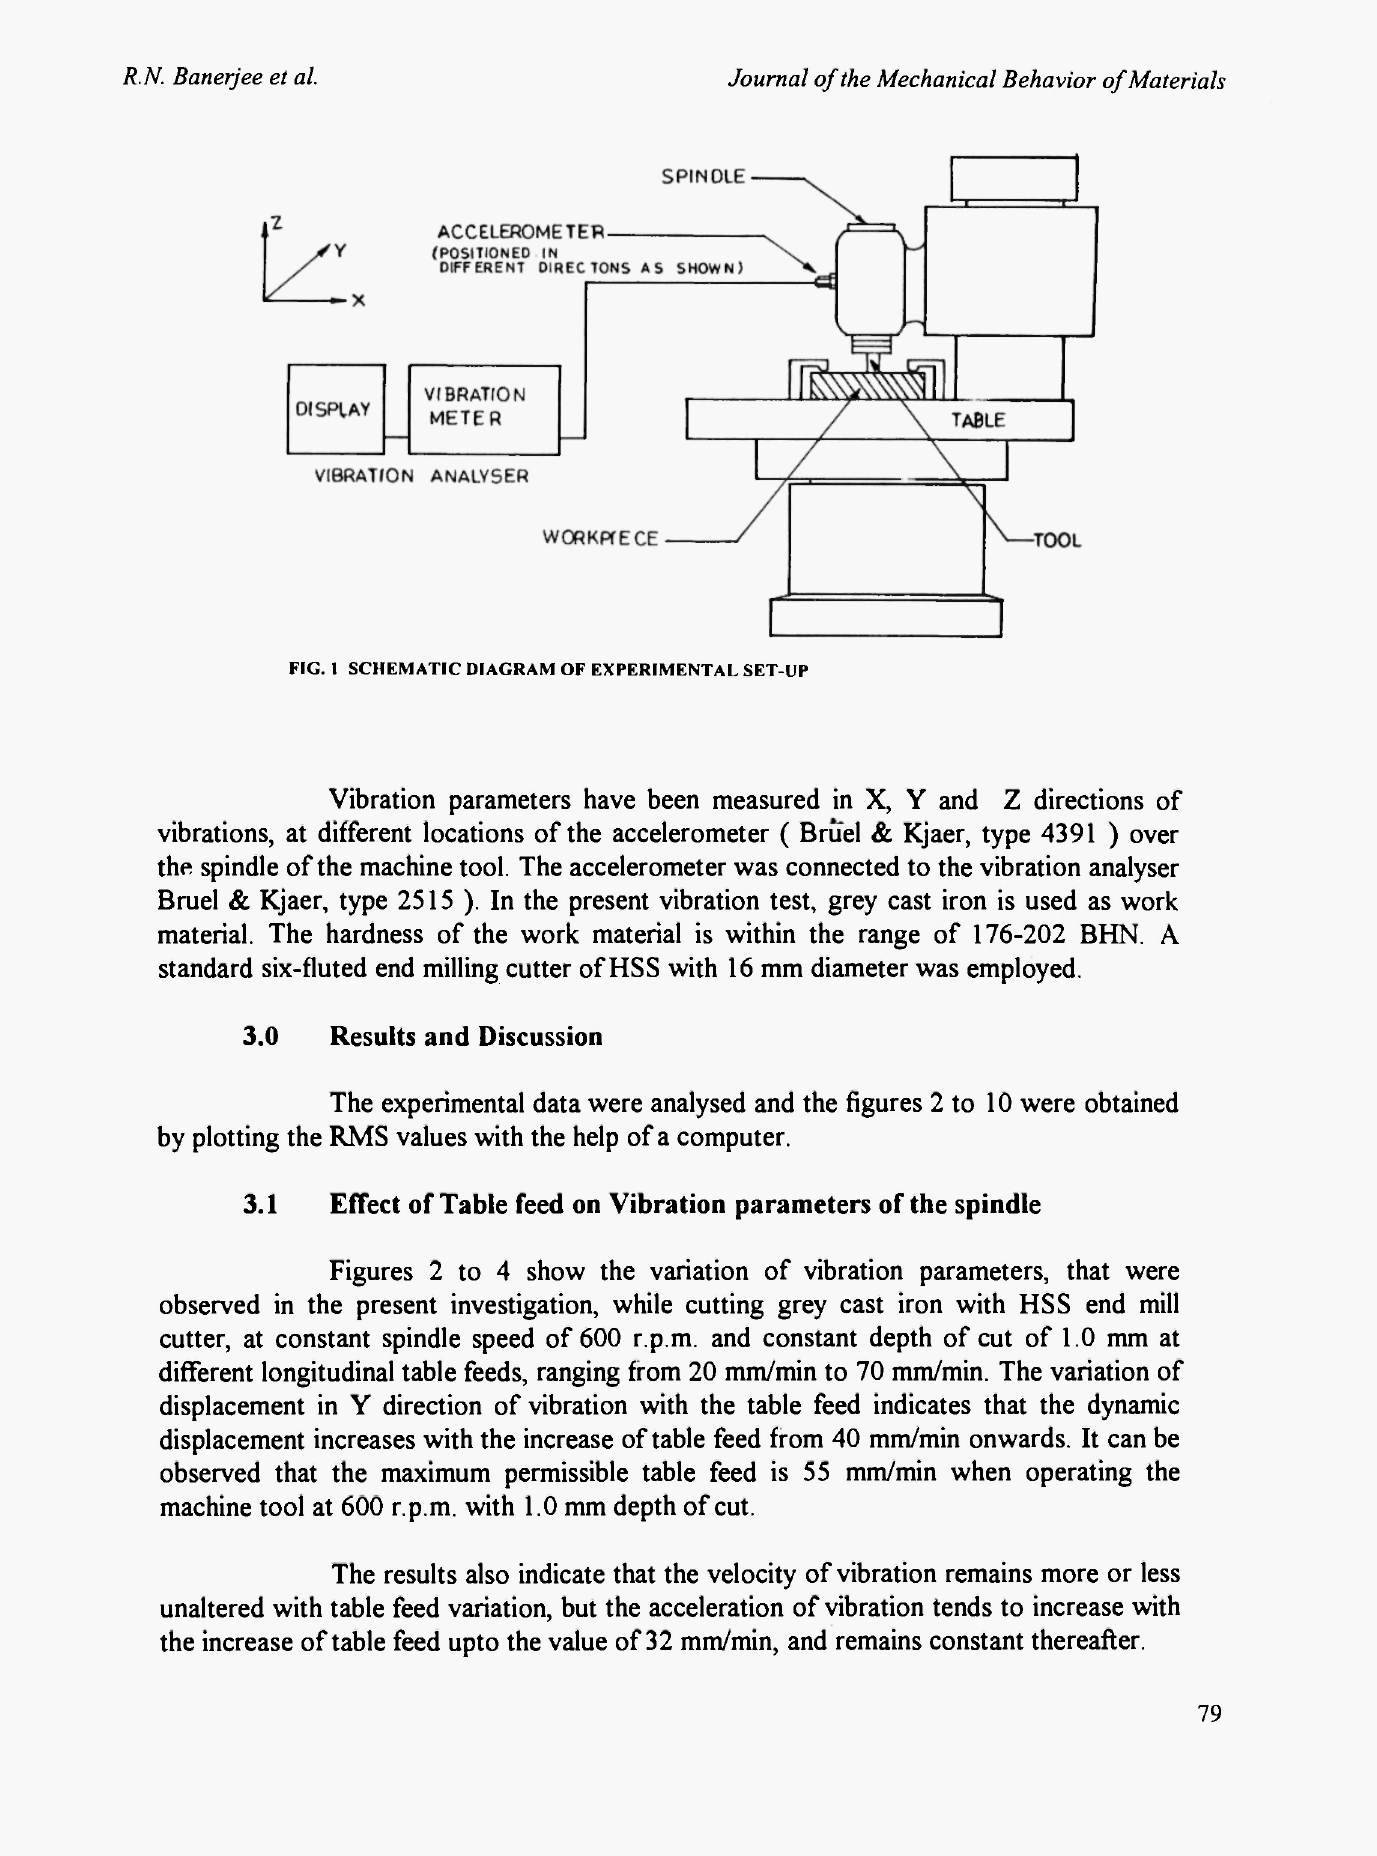
Vibration parameters have been measured in Χ, Y and Ζ directions